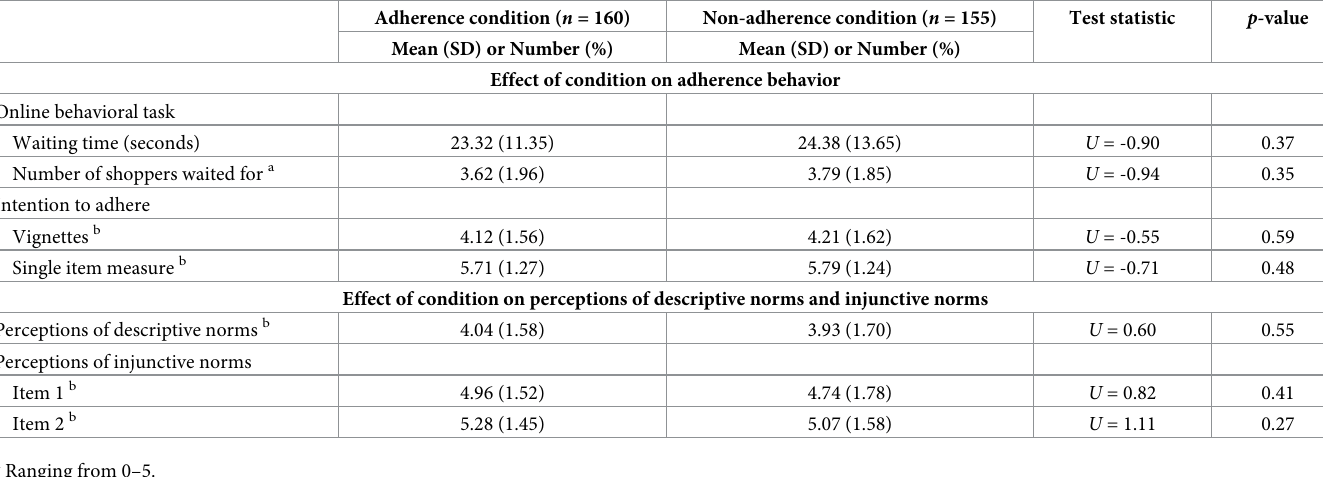
Table 4. Adherence behavior and the proposed mediators per condition ( n = 315), test statistic and p-value refer to non-parametric Mann-Whitney